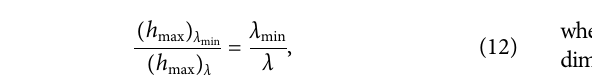
FIGURE2| Schematicdiagramofporousmedia. (A) 2Dstructureofporousmedia; (B) Cross-sectionofthecapillarywithaconstantdiameter; (C) Cross-sectionof the capillary with sinusoidal periodically constricted boundary.